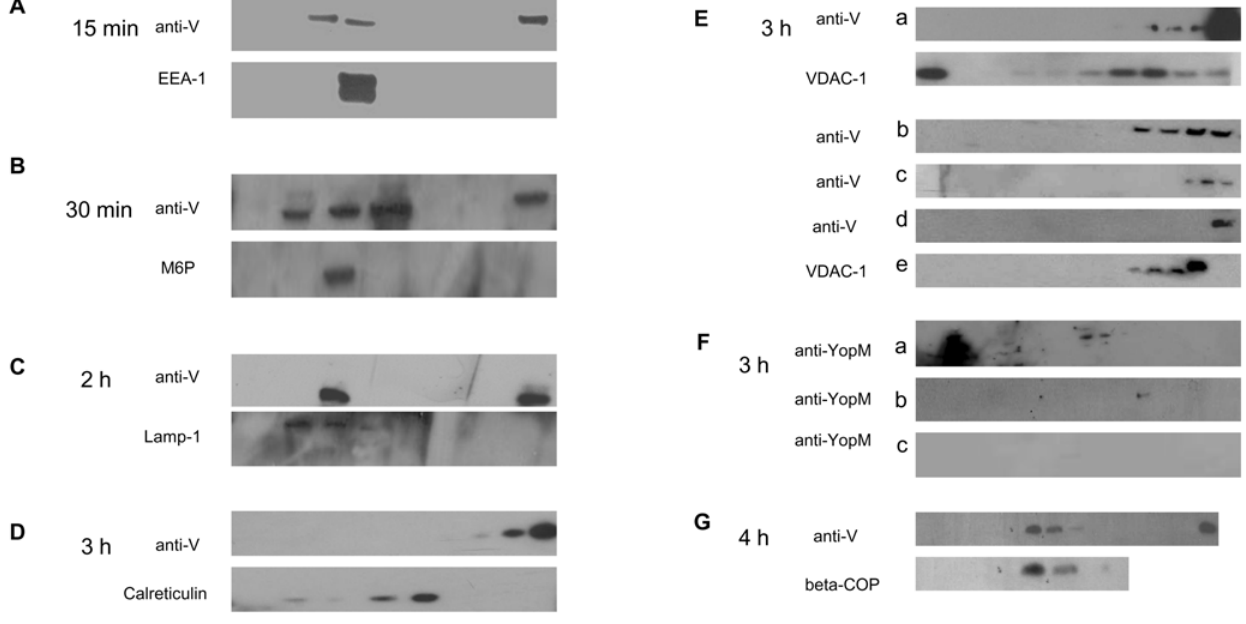
Figure 3. Trafficking of V as detected by density gradient centrifugation and immunoblot analysis. M F s were infected with CO92 pPst- pgm- (panels D-E-a, F-a-b, and G), SMI-pretreated CO92 pPst- pgm- (panels B, C, and F-c), or YpIII p(IB604) (panels A, E-c and E-e) for 15 min, 30 min, 2 h, 3 h, or 4 h. The fractions, or purified V (approx. 35 kD), were immunoblotted with anti-V Ab or with organelle-associated markers. The latter included Abs to EEA-1 (180 kD), M6P (31 kD), Lamp-1 (120 kD), VDAC-1 (31 kD), calreticulin ( , 63 kD) and b -COP (81 kD). After infection for 15 min (panel A), a band recognized by the anti-V mAb was observed in fractions that also contained bands detected by EEA-1 Ab. Similar patterns were observed for anti-V and Abs to: (panel B) M6P after 30 min of infection, (panel C) Lamp-1 after 2 h, (panels E) VDAC-1 after 3 h, and (panel G) b -COP after 4 h. At all time intervals tested, calreticulin ( , 63 kD) was not observed immunologically in fractions recognized by anti-V; a representative blot is shown in panel (D). M W s were also infected with for 3 h with Y. ptb. pTcrV (Panel E-b) or with the V-negative strain YpIII p(IB19) for 3 h (Panel E-d). In panel F, immunoblots were developed using anti-YopM Ab, to detect YopM in M F s that were not treated with cytoD (Panel F-a), treated with cytoD (Panel F-b), or treated and infected with SMI treated CO92 pPst- pgm- (Panel F-c) are